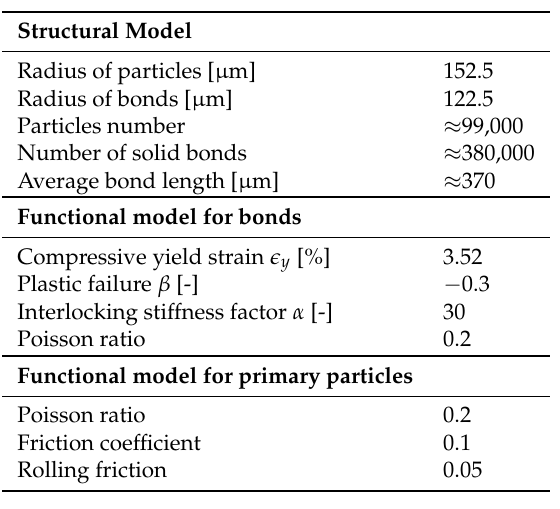
Table 1. BPM parameters used in the